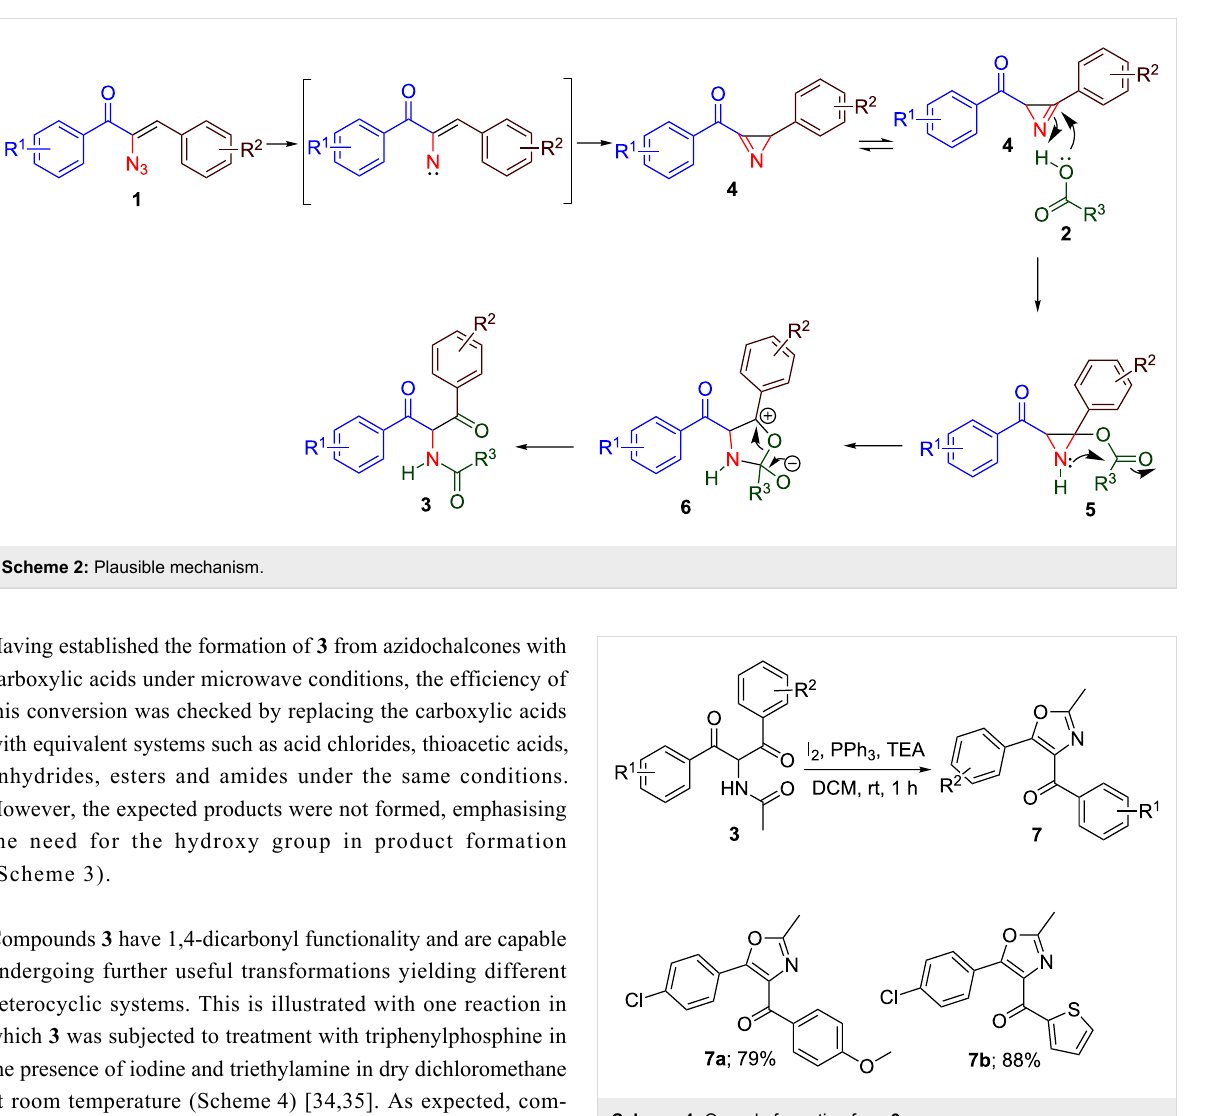
Scheme 4: Oxazole formation from 3